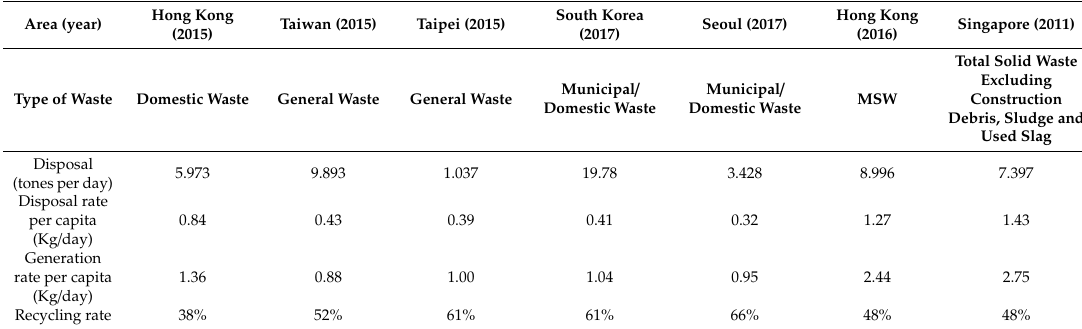
Table 2. Comparison of waste quantities among countries of